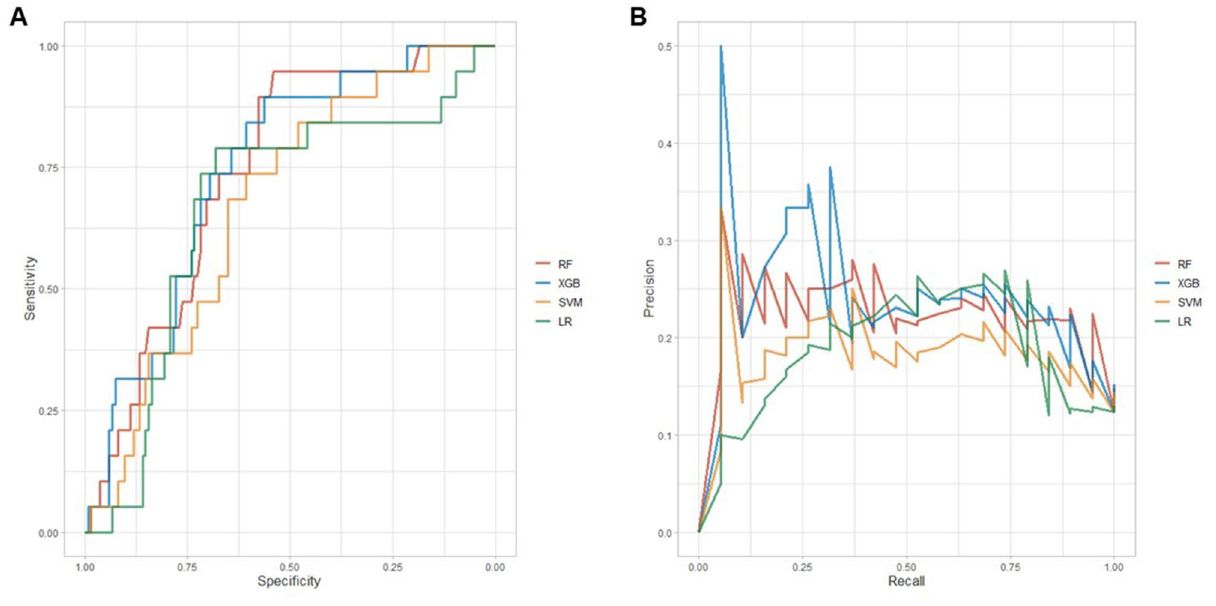
Figure 3. Receiver operating characteristic curve analysis ( A ) and precision–recall curve analysis ( B ) for each